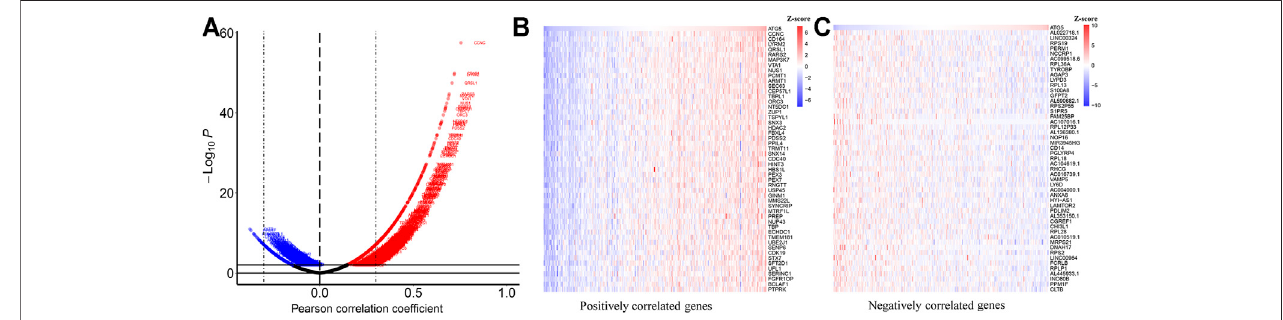
FIGURE 3 | Co-expression genes correlated with ATG5 in cervical cancer (LinkedOmics) (A) Pearson test was applied to analyze the correlation between ATG5 anddifferentiallyexpressedgenesinCervicalcancer.Bluedots(R < − 0.3, p < 0.01)represent asnegativelycorrelatedgenes,whilereddots(R > 0.3, p < 0.01)represent as positively correlated genes (B) Heat map showed the top 50 signi fi cant genes positively correlated with ATG5 (C) Heat map showed the top 50 signi fi cant genes negatively correlated with ATG5 (The expression of each in each heatmap is normalized with Z-score).